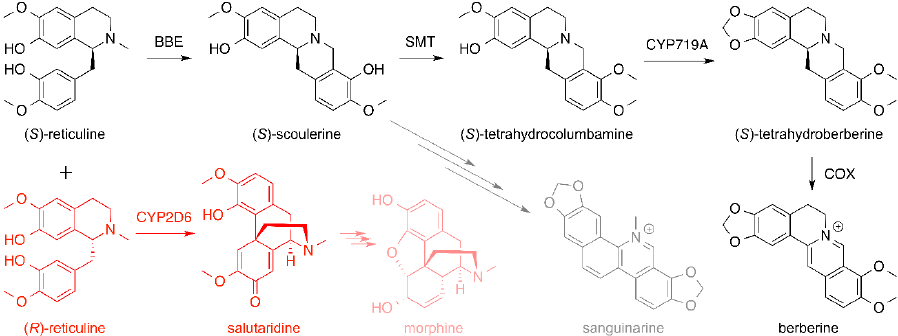
Figure 13. Extension of the Saccharomyces cerevisiae heterologous reticuline biosynthetic pathway for the production of precursors of the berberine- and sanguinarine-type benzylisoquinoline alkaloids (in black) and the morphinan alkaloids (in red). Compounds that are actually biosynthesized by the engineered yeast strains [71,72] are shown in solid, whereas downstream products are shown in semi-transparent. BBE, berberine bridge enzyme; SMT, ( S )-scoulerine 9- O -methyltransferase; CYP719A, canadine synthase cytochrome P450 719A; COX, canadine oxidase; CYP2D6, human cytochrome P450 2D6.